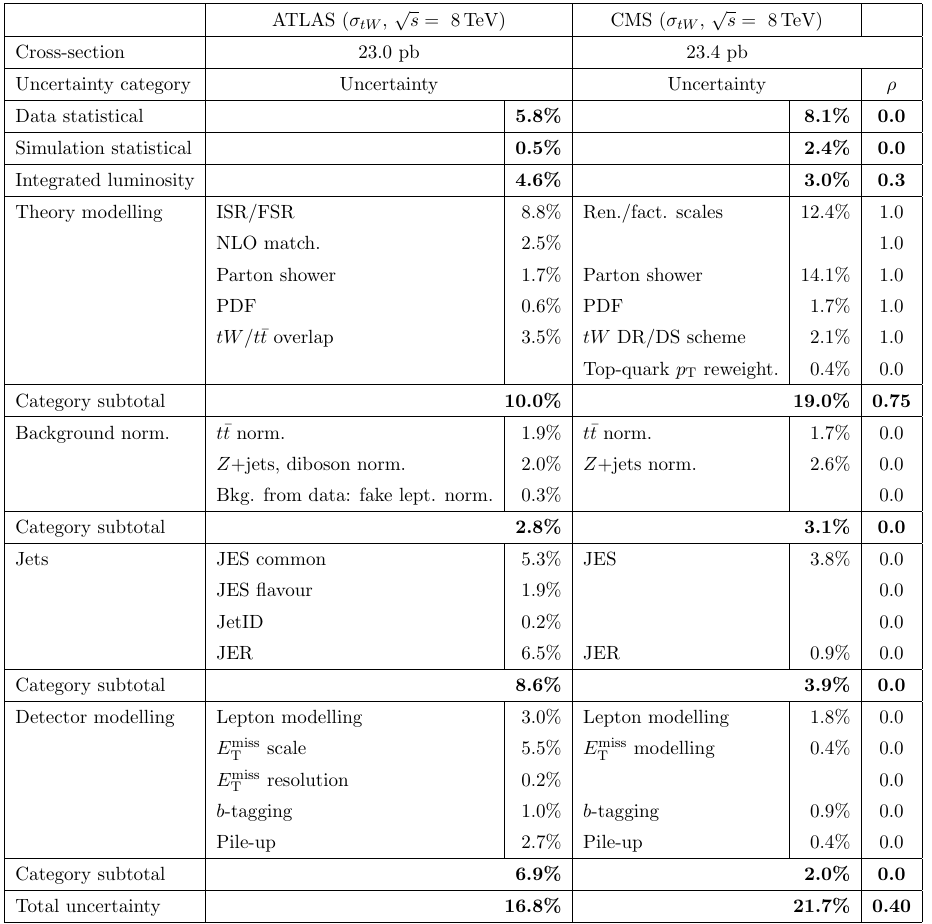
Table 12 . Measured cross-sections, uncertainty components, their magnitudes (relative to the individual measurements) and the correlation ( (cid:26) ) between the ATLAS and CMS (cid:27) tW measurements at p s = 8 TeV. Uncertainties in the same row can be compared between experiments, as detailed in the text. The naming conventions follow those of the corresponding